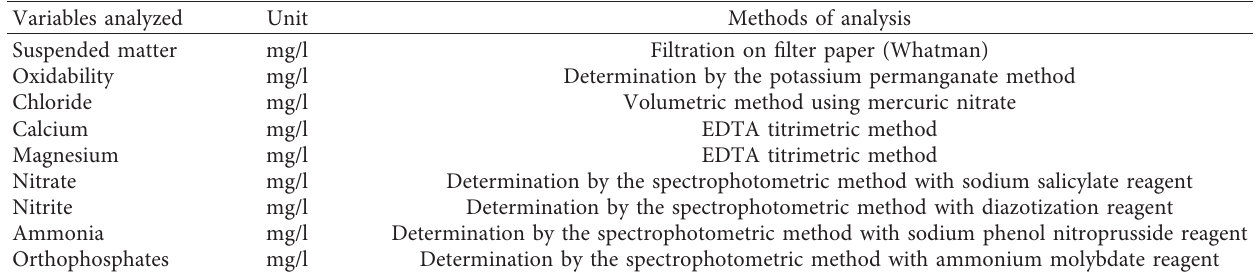
Table 1: Analysis methods of the physicochemical variables.